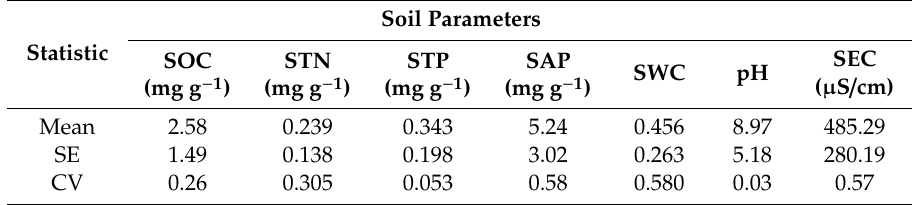
Table 3. General information about soil parameters in the Guazhou Common